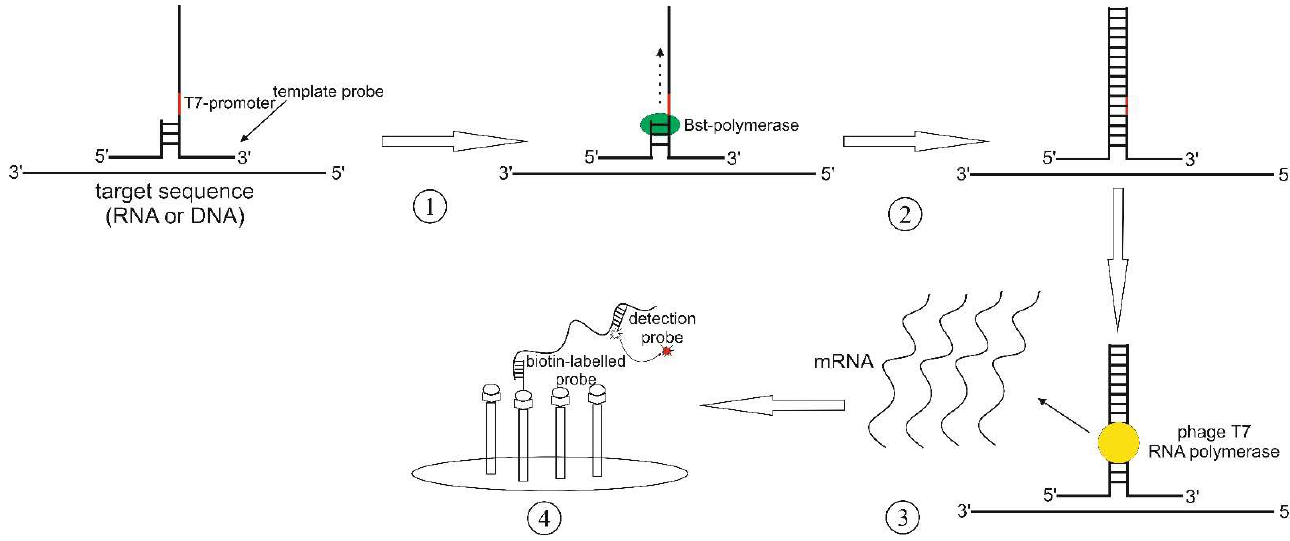
Figure 4. SMART scheme: (1) 3-way junction (3WJ) formation; (2) synthesis of the second strand by the Bst DNA polymerase; (3) synthesis of the specific mRNA; (4) detection of the synthesized RNA fragment by a specific detection probe that is annealed to a biotin-labeled probe.